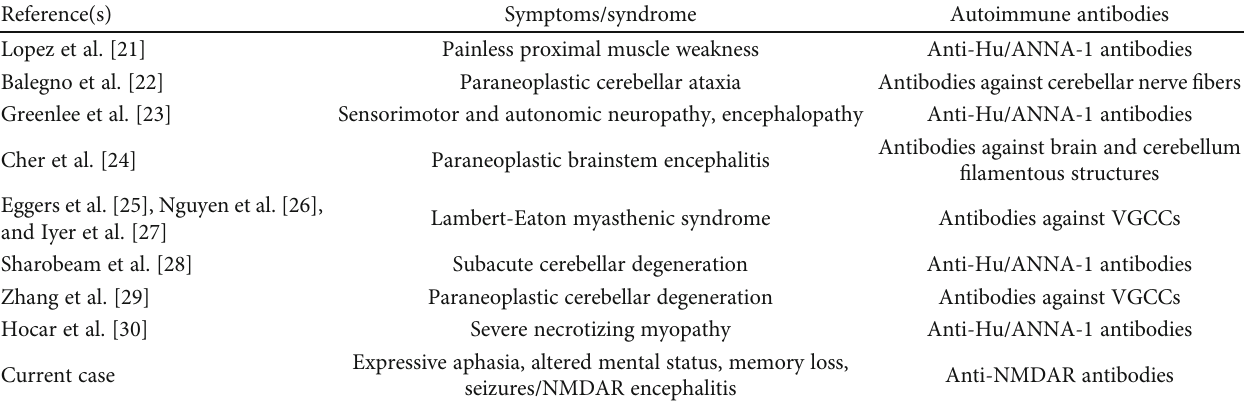
Table 2: Autoimmune paraneoplastic syndromes associated with Merkel cell